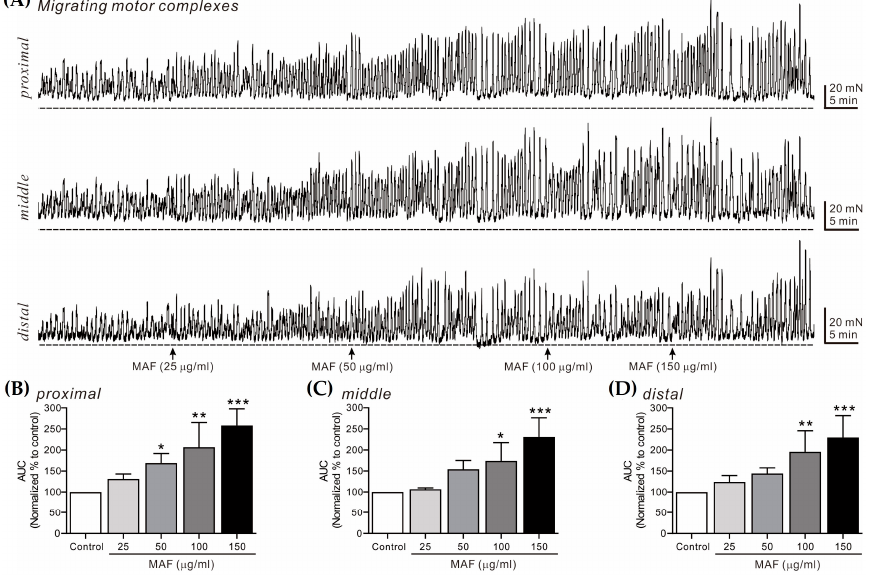
Figure 6. E ff ects of MAF on MMCs in human ileal segments in situ. ( A ) Representative raw traces showing that MAF increased MMCs in human ileum at the proximal, middle, and distal sites in a dose-dependent manner (25–150 µg/mL). Arrows indicate the points of MAF administration. Do tt ed lines indicate the baseline tension. ( B – D ) Summarized graphs showing the e ff ects of MAF on AUC at three di ff erent sites of the ileal segment. Signi fi cant di ff erence (* p < 0.05, ** p < 0.01, and *** p < 0.001) compared with control.